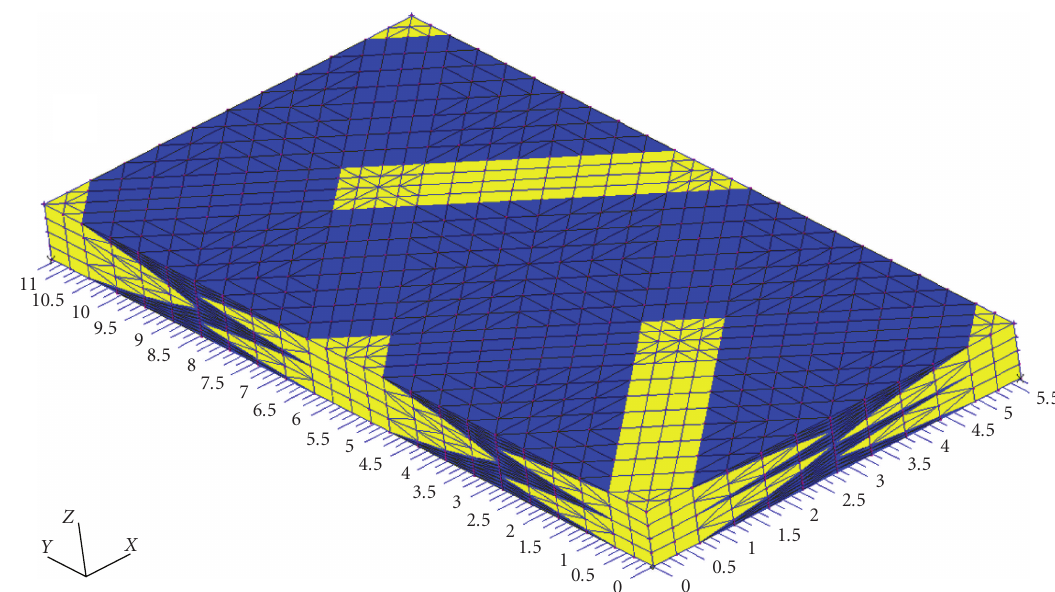
Figure 9: View of the carbon-braided RUC with matrix elements (blue) and fiber tow (yellow).